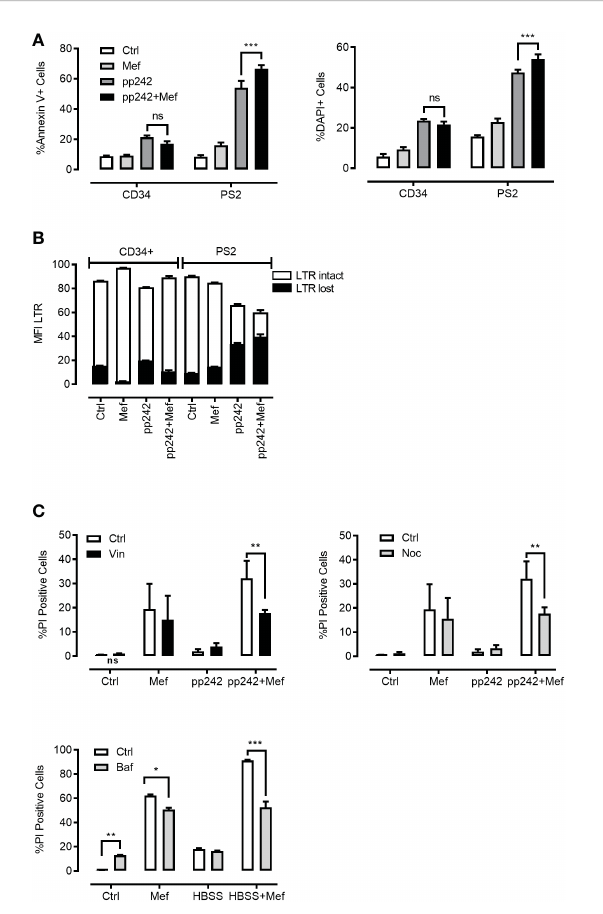
FIGURE 5 Effect of combination of me fl oquine and mTOR inhibition on cell viability. (A, B) Patient 2 derived leukemic blasts (PS2) and CD34+ cells from healthy donors were treated with me fl oquine (10 m M) and pp242 (5 m M) for 48 h and stained with Annexin V (left panel) or DAPI (right panel). Data are presented as mean ± S.D. Statistical tests were performed by Two-way ANOVA Sidak ’ s multiple comparison test. *** indicates p<0.001. Lysosome disruption leads to a decrease in the viability of cells after 48 h of drug treatment (B) . Data are presented as mean ± S.D. and are representative for 1 independent experiment with 2-3 replicates. (C) HL60 cells were incubated with pp242 (5 m M), me fl oquine (10 m M) with and without vinblastine ( left panel ), nocodazole ( right panel ) for 48 h. THP1 cells were incubated with HBSS and me fl oquine (10 m M) for 24 h in the presence and absence of Ba fi lomycin A1( lower panel ). Cell death was measured using propidium iodide (PI) staining on a fl ow cytometer. Data represent mean ± S.D. and is representative of 1-2 independent experiments each with 1-3 replicates. *p < 0.05, **p < 0.01, ***p < 0.001 by Two- way ANOVA with Sidak ’ s multiple comparison test *P < 0.05; **P < 0.01; ***P <